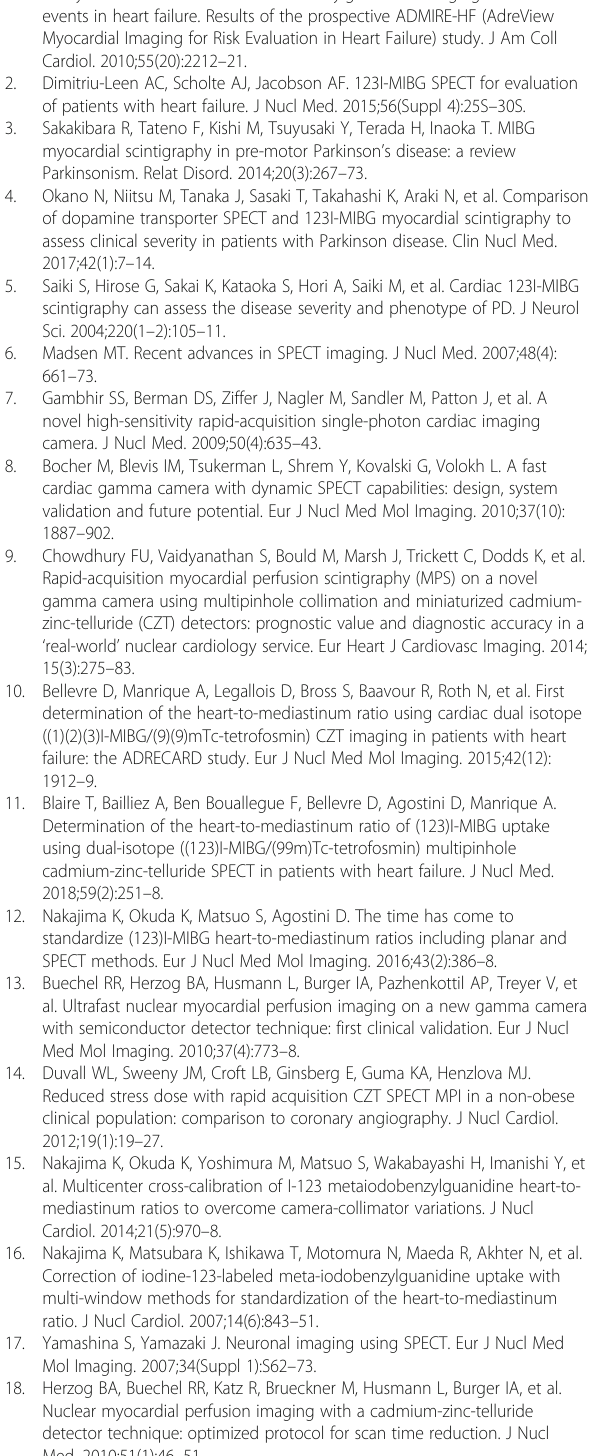
Additional file 1: Figure S1 . Details of phantom models. Figure S2 . Correlation between reference HMRs and difference of HMRs (300s −